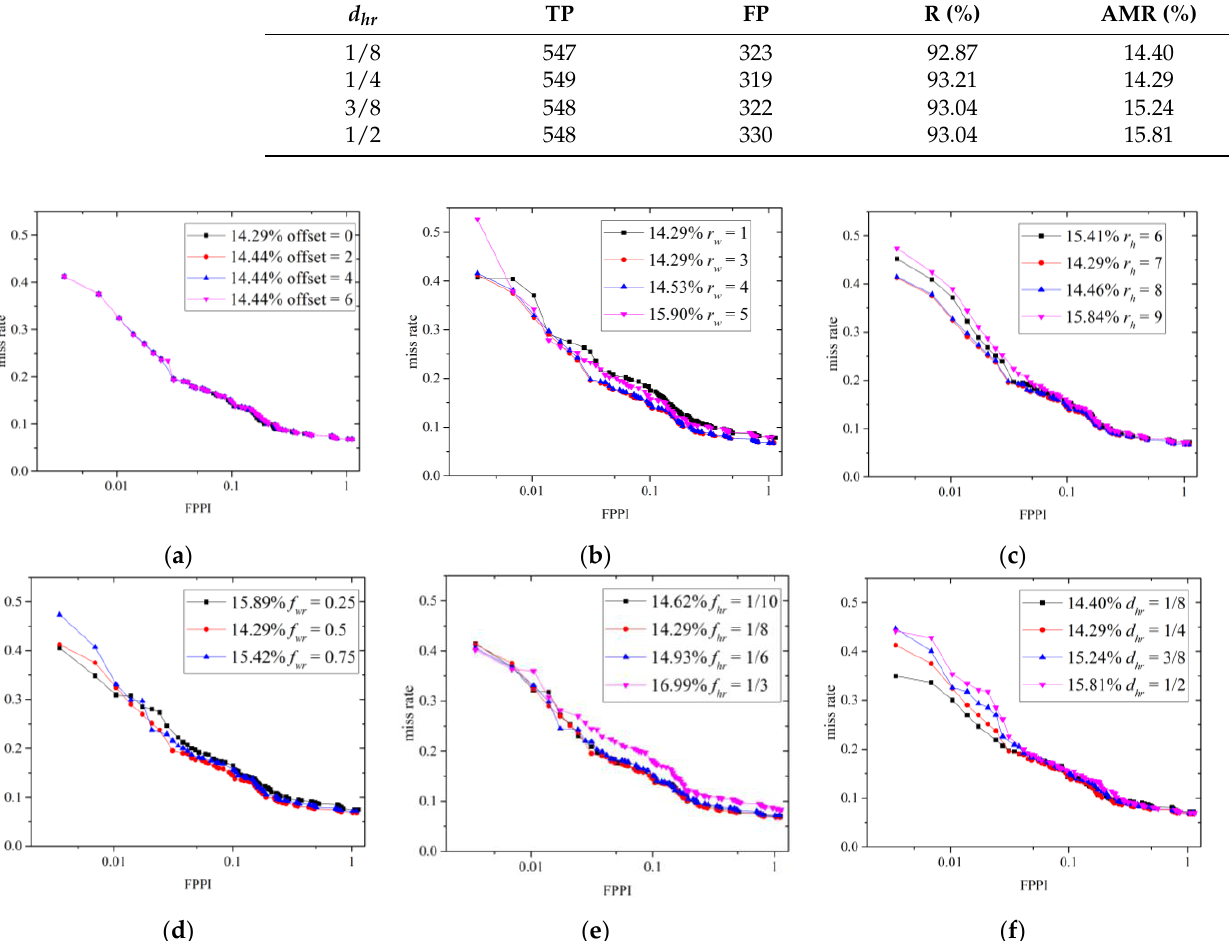
( d ) Figure 19. The choices of 𝑠 𝑡ℎ𝑟 and 𝑓 𝑠𝑠 mutually influence the number of true positives ( a ), the num- ber of false positives ( b ), the recall ( c ), and the average miss rate ( d ). According to Table 1 and Figure 18a, the same recall and 3 more false positives are produced when the 𝑜𝑓𝑓𝑠𝑒𝑡 increases from 0 to 6. This shows that the contribution of the 𝑜𝑓𝑓𝑠𝑒𝑡 is not obvious in our setup. A value of 𝑜𝑓𝑓𝑠𝑒𝑡 = 0 is recommended when one wishes to minimize false positives. Tables 2 and 3 and Figure 18b,c show that 𝑟 𝑤 = 1– 4 and 𝑟 ℎ = 7, 8 can produce the maximum number of true positives. Increasing 𝑟 𝑤 and 𝑟 ℎ leads to less false positives, because relatively small sliding windows are filtered out. However, some true positives are also eliminated when 𝑟 𝑤 and 𝑟 ℎ are too large. To main- tain as many true positives as possible, 𝑟 𝑤 = 1 and 𝑟 ℎ = 7 are recommended. As for the score scaling and assigning, the anchor best locates at the middle of the width ( 𝑓 𝑤𝑟 = 0.5 ) and 1/8th of the height ( 𝑓 ℎ𝑟 = 1/8 ), as presented in Tables 4 and 5 and Figure 18d,e. This location is in line with the face positions of the most upright adult human bodies. Table 6 and Figure 18f show that the best 𝑑 ℎ𝑟 is 1/4. As shown in Figure 19a – c, 𝑠 𝑡ℎ𝑟 is inversely proportional to the number of true positives, false positives, and recall, whereas 𝑓 𝑠𝑠 is directly proportional to them. This is because a higher threshold brings in fewer bounding